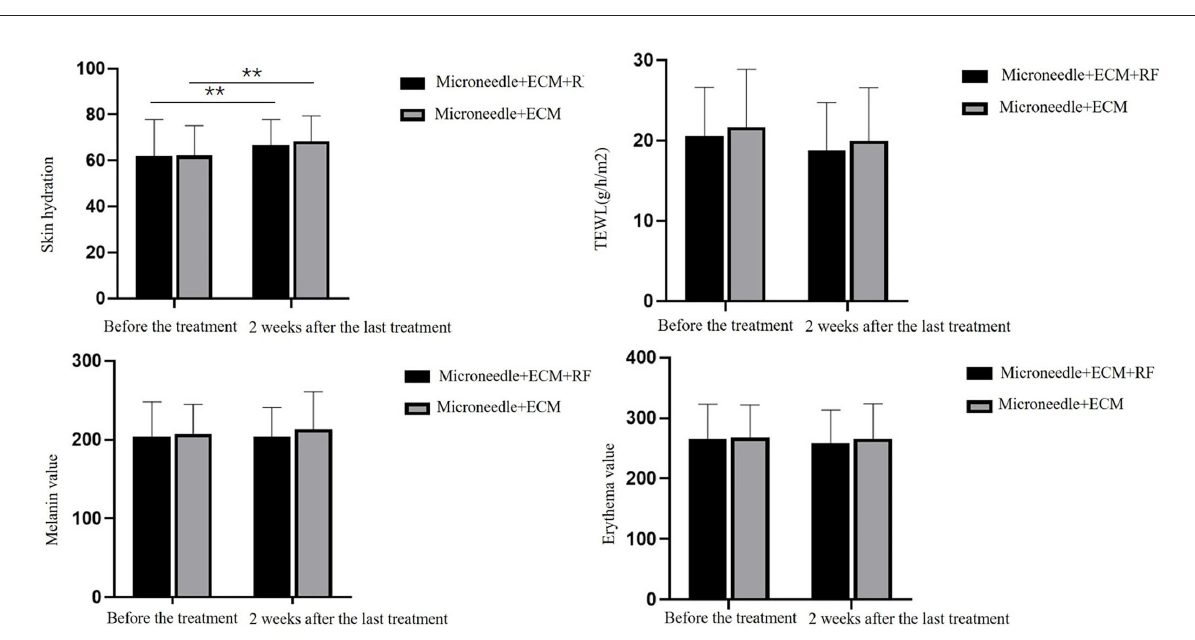
FIGURE1 Comparison graph of biophysical parameters measured by CK. TEWL, transepidermal water loss. ** p <